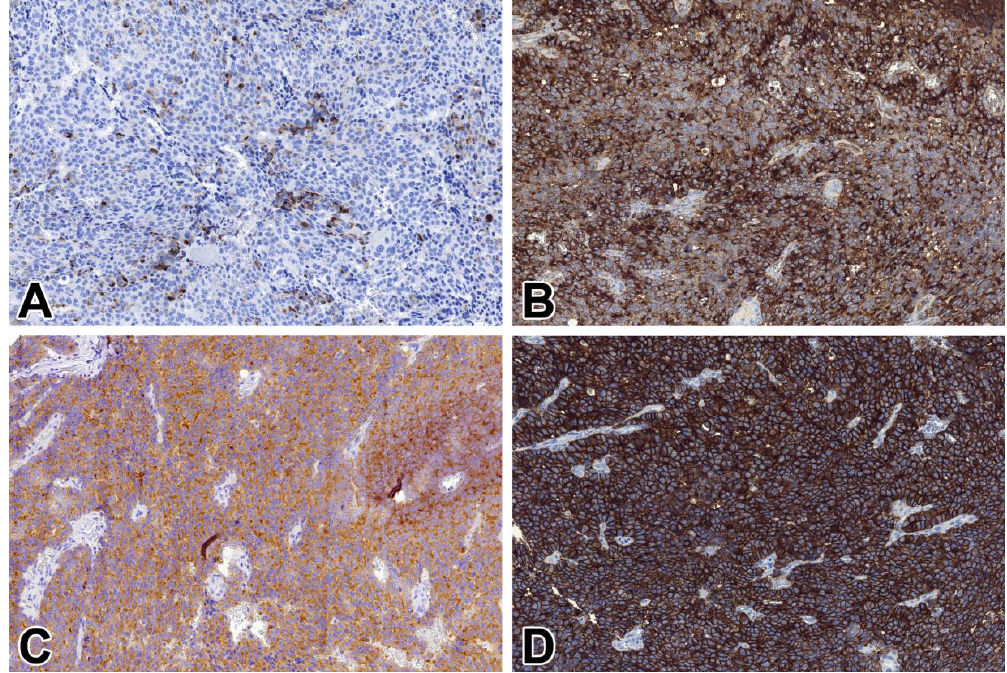
Figure 4. CD56, CHGA, SYP, and STX1 immunoreactivity in a pancreatic large cell NE carcinoma (NEC). ( A ) CD56, 20x; ( B ) CHGA, 20x; ( C ) SYP, 20x; ( D ) STX1,